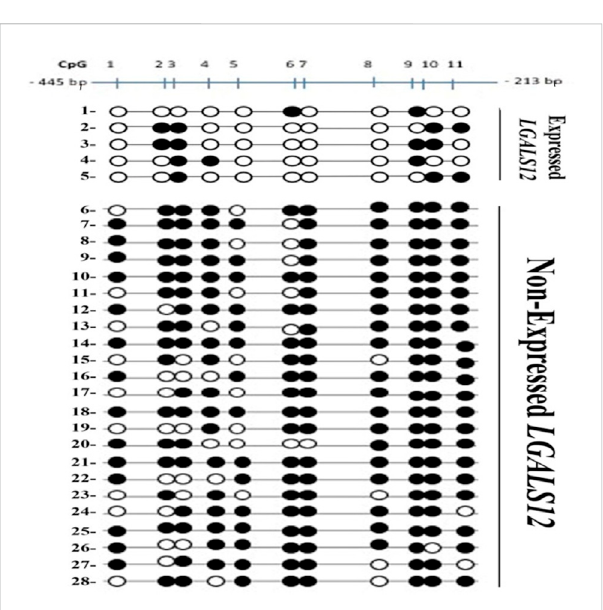
Bisul fi te Genomic Sequencing of the promoter region of LGALS12 . Methylation status of CpGs of Gelactin-12 promoter. CpGs are shown aseitherblack (methylated) orwhite (unmethylated)circles and are numbered by Roman